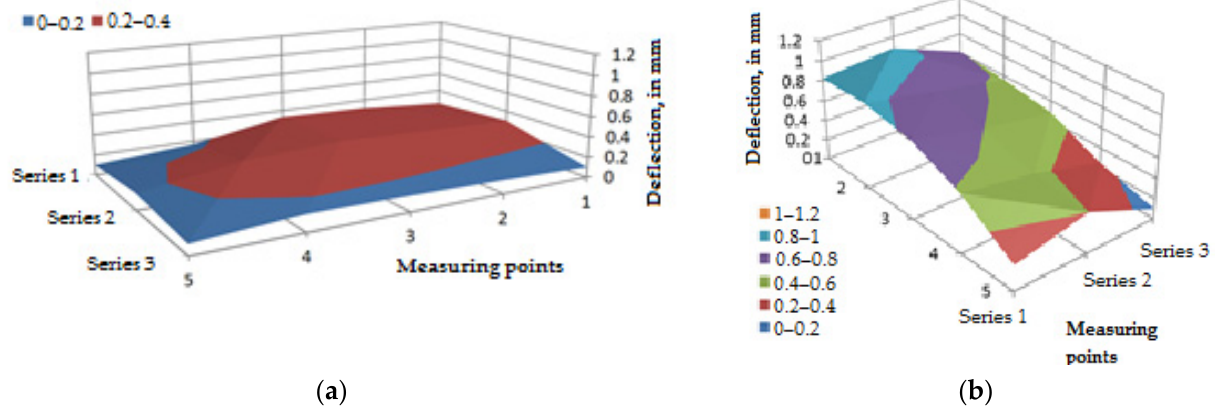
Figure 9. Deflection values and warpage of blockboard with HDF faces tested in the bathroom: ( a ) at the beginning of the experiment; ( b ) after three months of exposure in the bathroom.